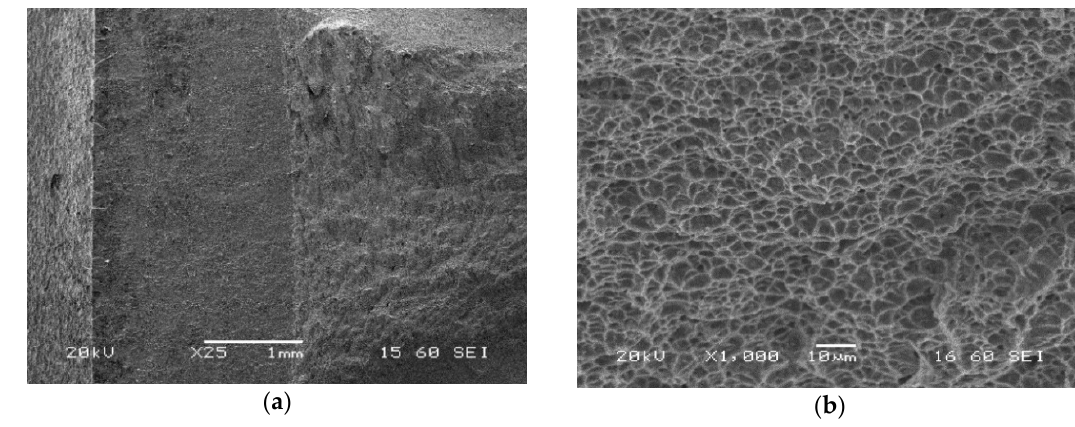
Figure 21. Microstructures of the zone located in the transition region of the weld (specimen No. 3) obtained during CTOD test using SEM; magnifications: ( a ) ×25; ( b ) ×1000. Despite the unstable crack growth in HAZ, the CTOD parameter in this zone took the highest value. It was equal to 0.386 mm (Figure 22). In comparison to values calculated for the parent material and weld, it was 37% higher.